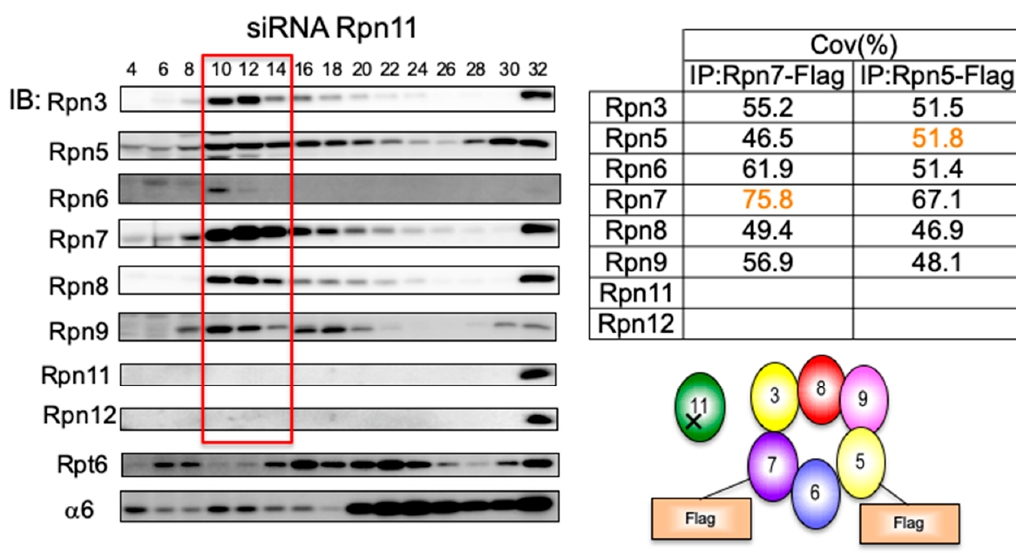
Figure 4. Loss of Rpn11 does not affect the assembly of other lid subunits but affects lid–base joining. HEK293T cells stably expressing Rpn5-Flag and Rpn7-Flag treated with siRNA targeting Rpn11 were